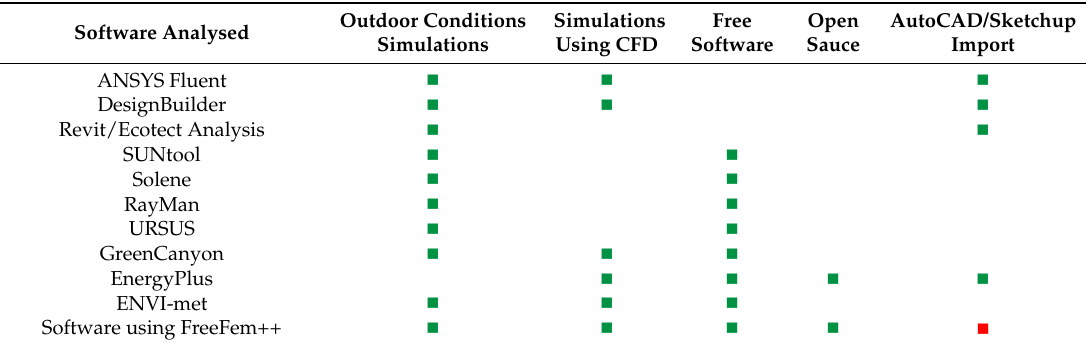
Figure 1. 2D example of building geometry.